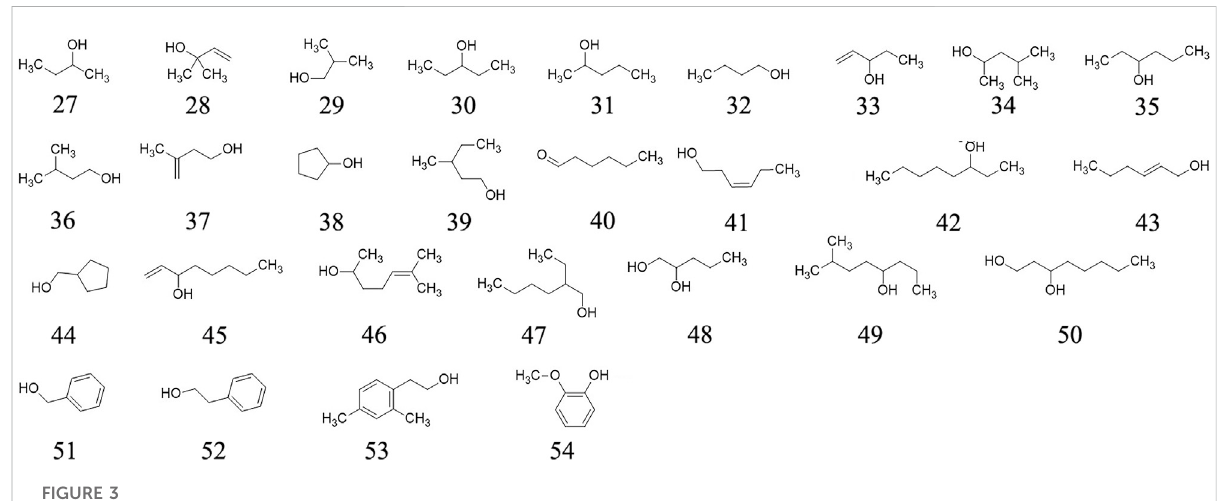
FIGURE 3 Alcohols determined from A. eriantha .